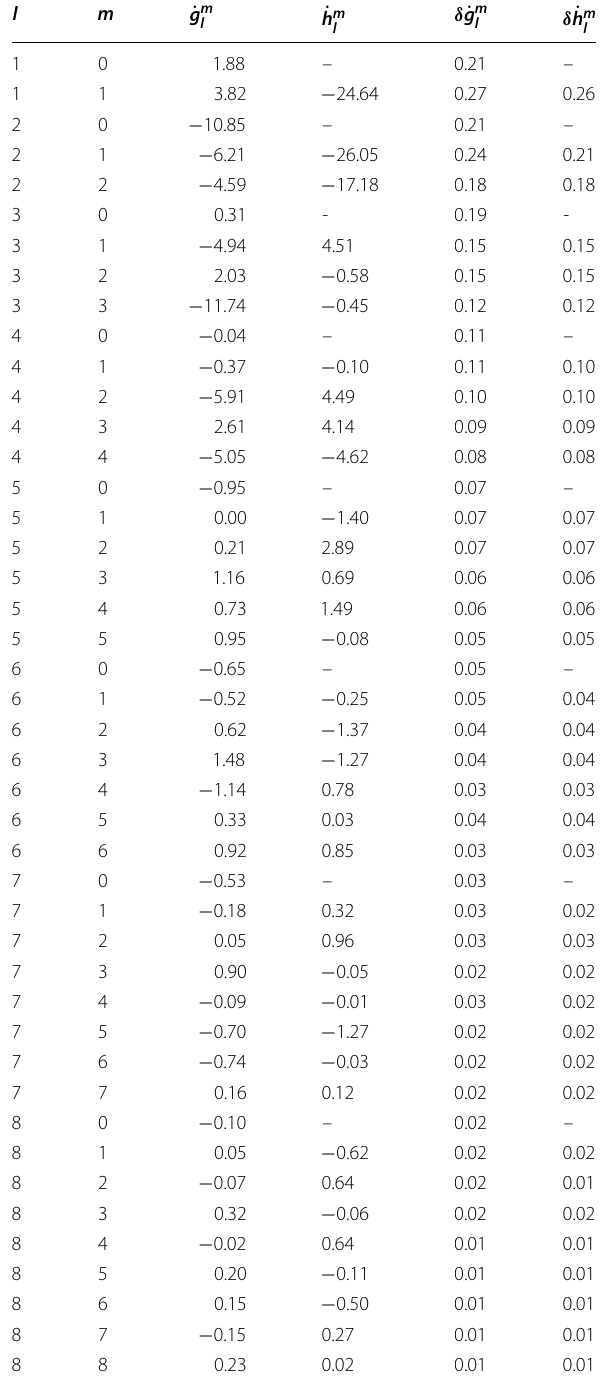
Table 3 Derived SV candidate